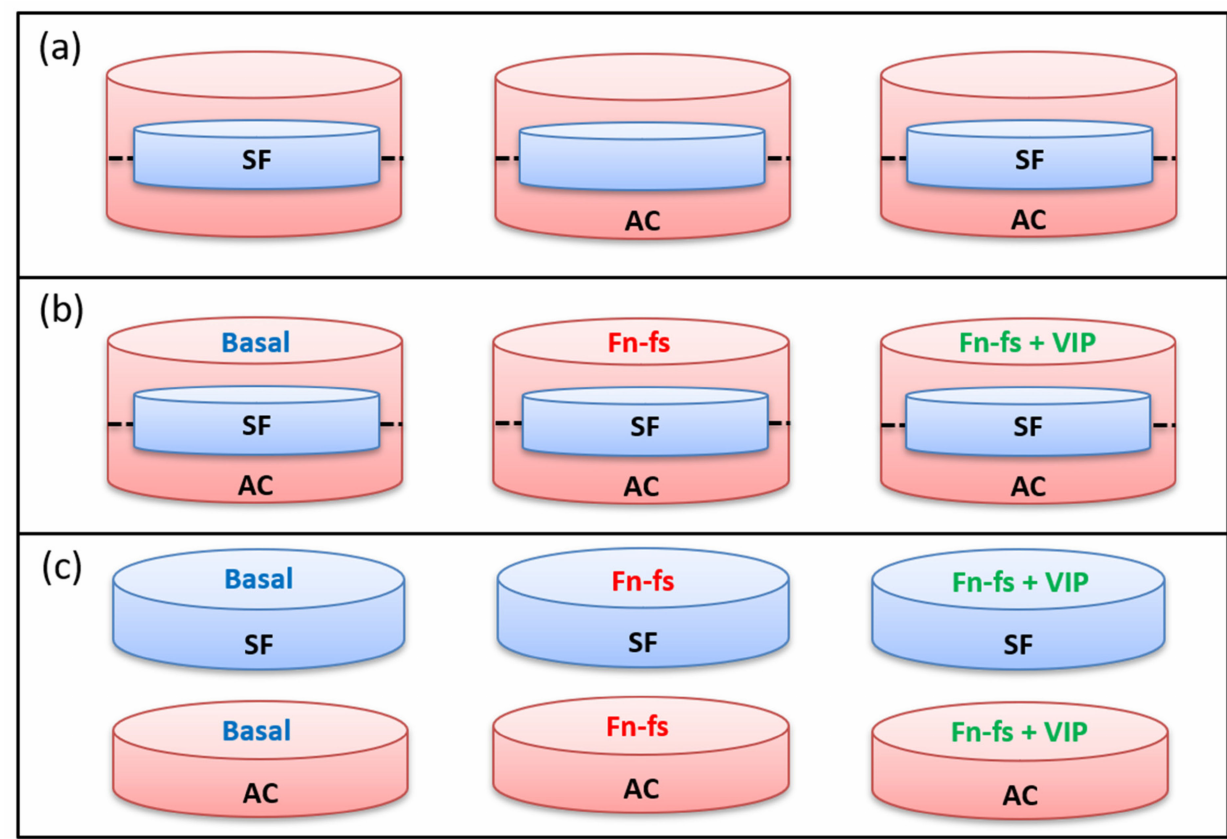
Figure 8. Experimental design of SF and AC co-cultures and isolated cultures for ELISA and Multiplex analysis. ( a ) Basal conditions in the SF-AC transwells. ( b ) Treatments of SF-AC co-cultures. ( c ) Treatments of SF and AC isolated cultures. SF, synovial fibroblasts; AC, articular chondrocytes; Fn-fs, fibronectin fragments; VIP, vasoactive intestinal peptide. A schematic representation of the whole experimental design is shown in Figure